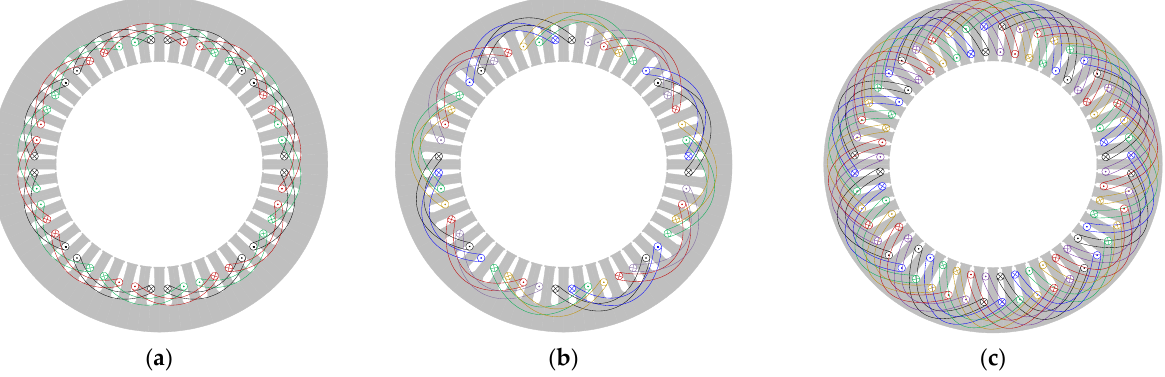
Figure 4. Winding arrangements of different winding configurations: ( a ) ORG; ( b ) DTP-SF; ( c ) DTP-DS.